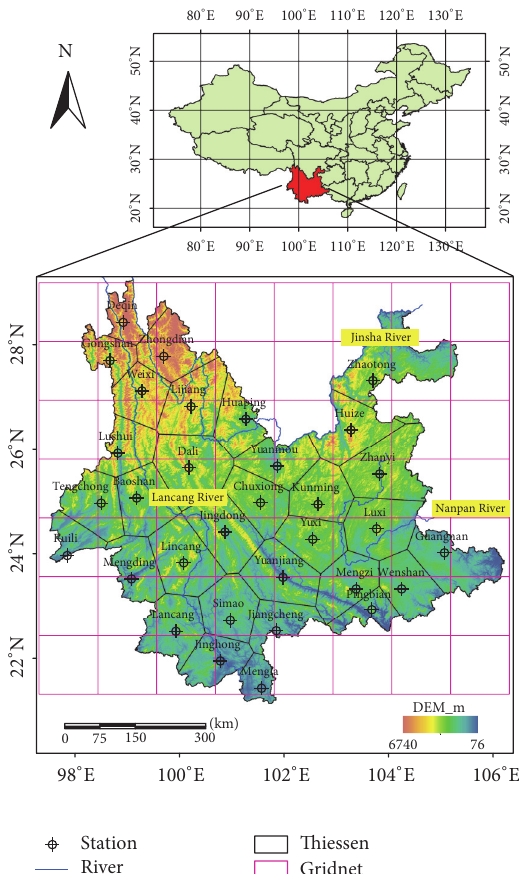
Figure 1: Basin profile and distribution of meteorological stations in Yunnan province.